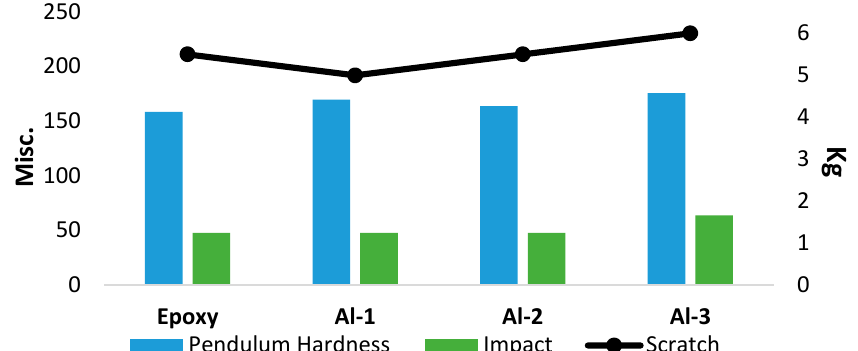
Figure 4. Graphical representation of the coating’s obtained mechanical properties.